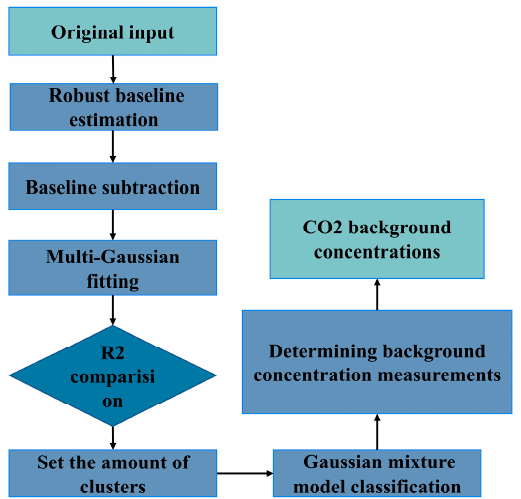
Figure 1. Algorithm flow.